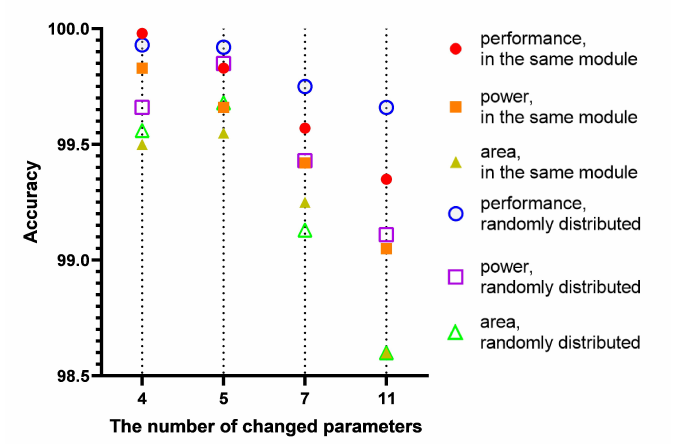
Figure 4. ML-PM on the same number of changed parameters in the same modules and randomly distributed.